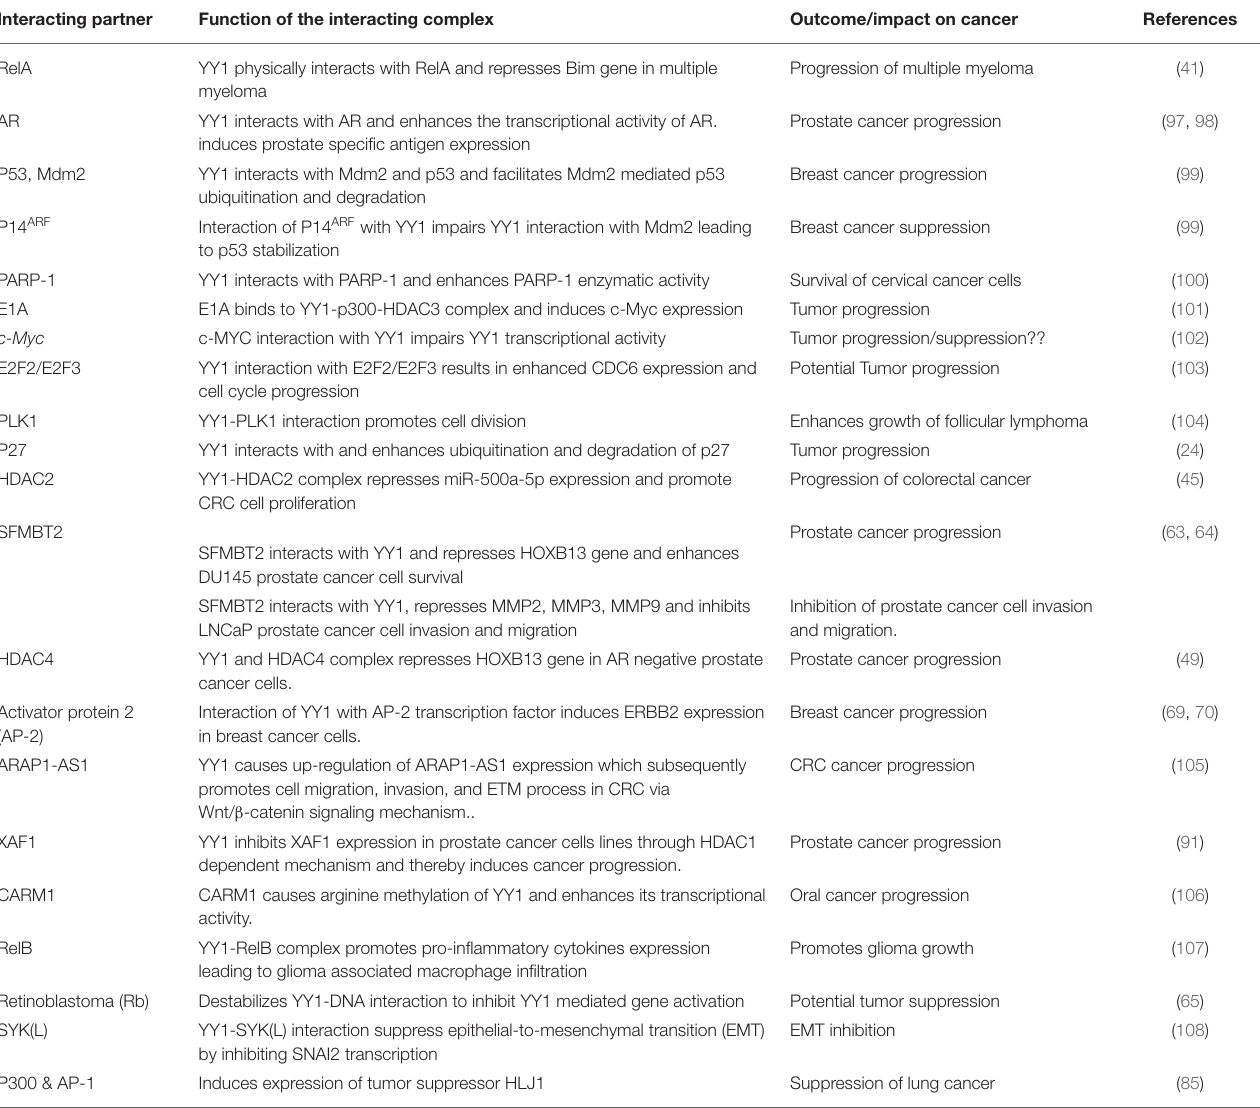
TABLE 3 | YY1 Protein-protein interactions and their role in cancer progression/suppression. Interacting